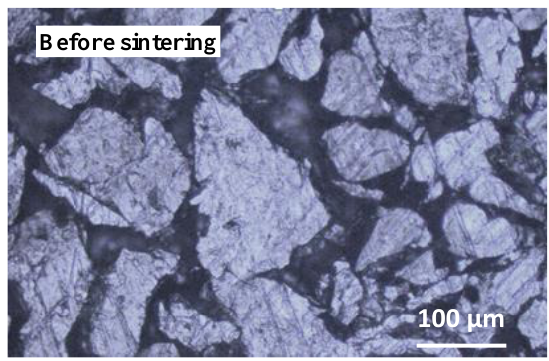
100 µ m Figure 14. Micrography of a 800 mg Cr pellet before sintering (optical microscope). Figure 14. Micrography of a 800 mg Cr pellet before sintering (optical